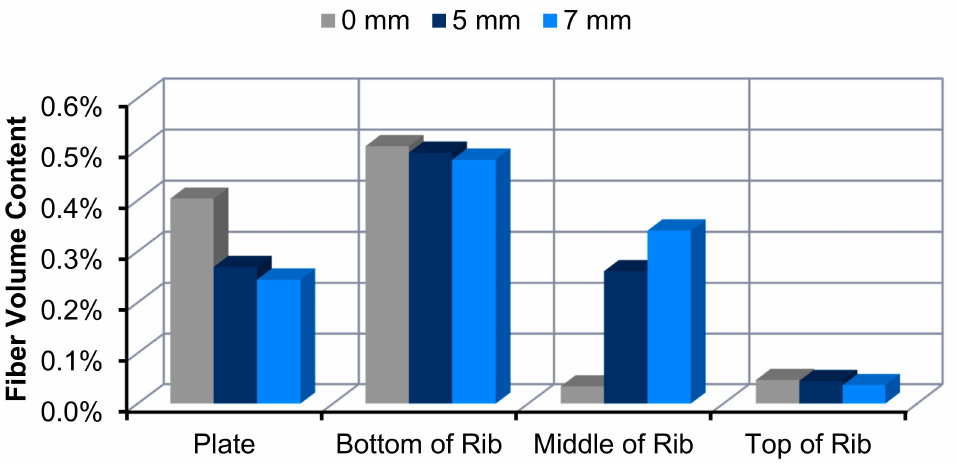
Figure 14. Volume fraction throughout rib for different rib entrance radii. All simulations used a center charge with 20 mm fibers and a random orientation.